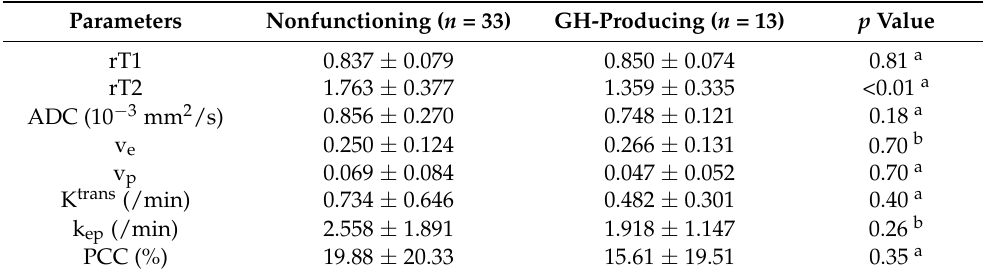
Table 3. MRI parameters and histologic percentage of collagen content of nonfunctioning and GH producing